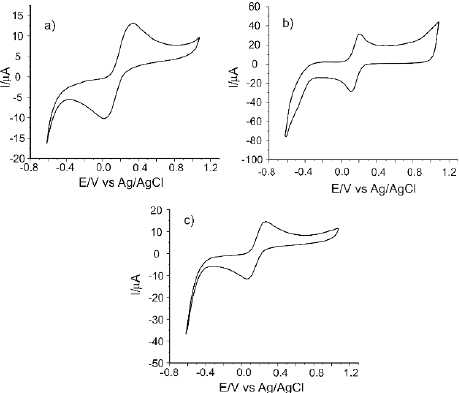
Figure 1. The cyclic voltammograms of ( a ) carbon-based screen-printed electrodes (C-SPEs), ( b ) carbon nanofiber (CNF)-modified C-SPEs and ( c ) multiwalled carbon nanotube (MWCNT)-modified C-SPEs immersed in 10 − 3 M K 4 [Fe(CN) 6 ] - 0.1 M KCl solution. Scan rate 0.1 V·s − 1.